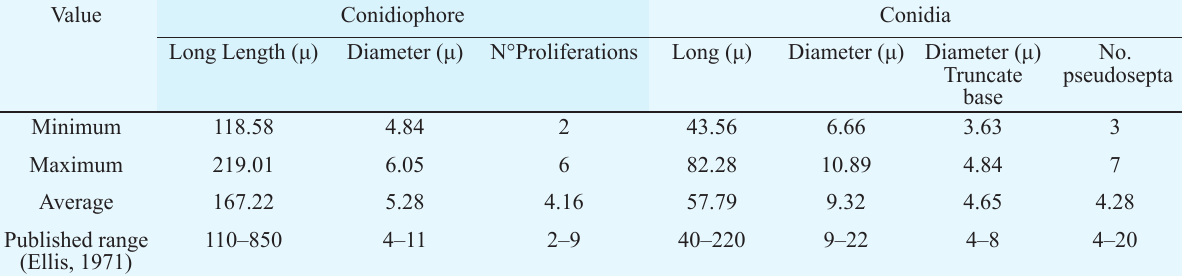
3. Average measurements of the conidiophore and conidia that were reisolated from strawberry ( Fragaria ananassa ) plants in the pathogenicity test.